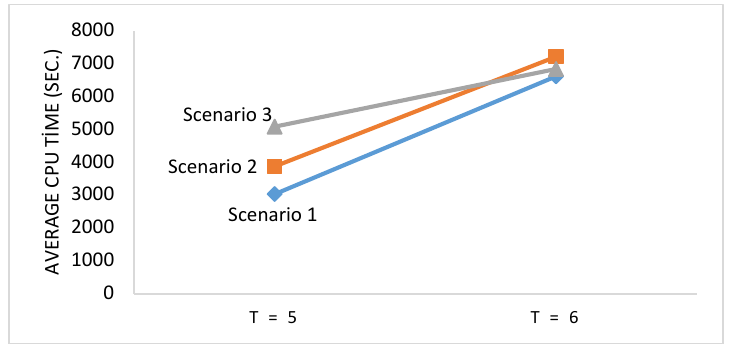
Fig. 7. Effect of 𝑇 on the average CPU time for 𝑉 = 3 (MILP-D model)